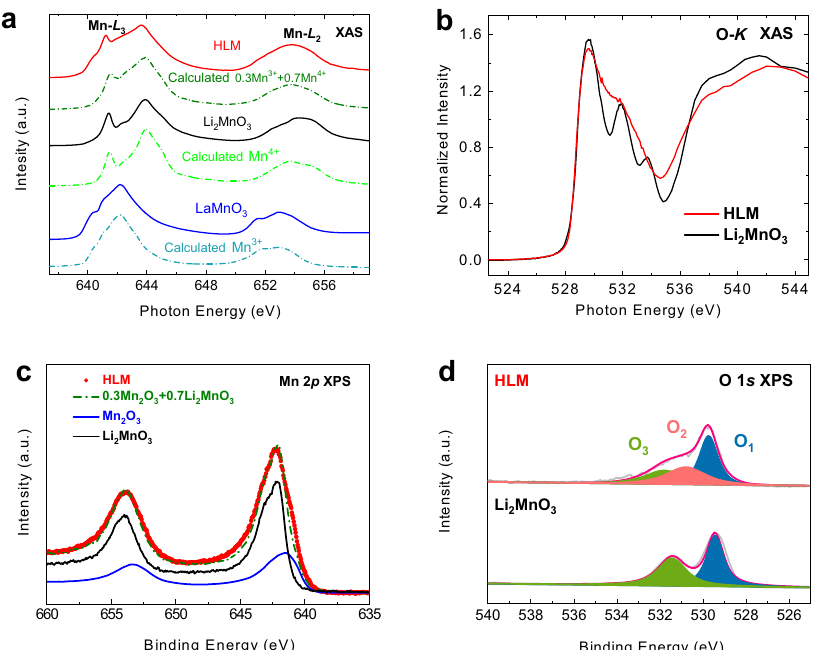
Fig. 2 Electronic structure characterization by XAS and XPS. a Mn- L 2,3 XAS spectra of HLM (red) together with Li 2 MnO 3 (black) and LaMnO 3 35 (blue) as Mn 4 + and Mn 3 + references. The dashed lines below the experimental data are the corresponding calculated spectra. b O- K XAS spectra of HLM (red) and Li 2 MnO 3 (black). c High-resolution Mn 2 p XPS spectra of HLM (red) and sum (olive) of Mn 2 O 3 (blue) and Li 2 MnO 3 (black). d High-resolution O 1 s XPS spectra of the as-prepared HLM and pristine Li 2 MnO 3